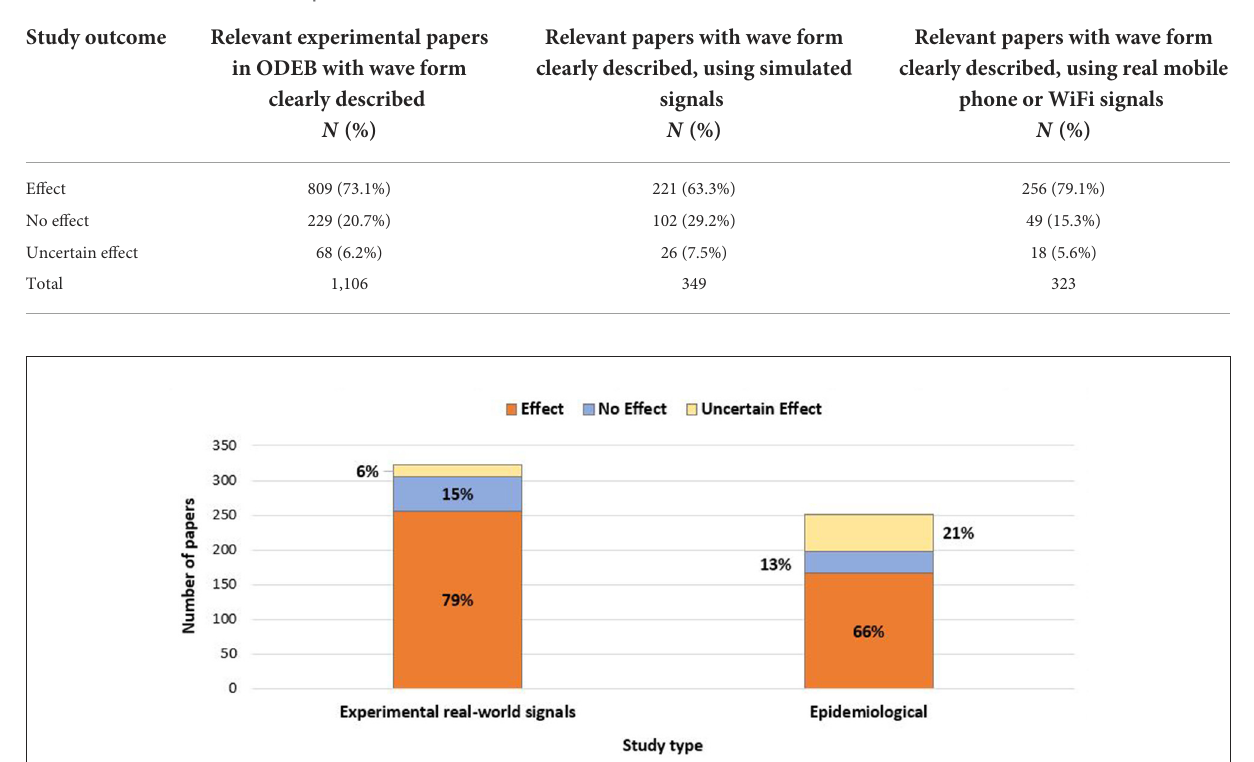
TABLE 1 Outcomes for selected experimental ( in vitro and in vivo )